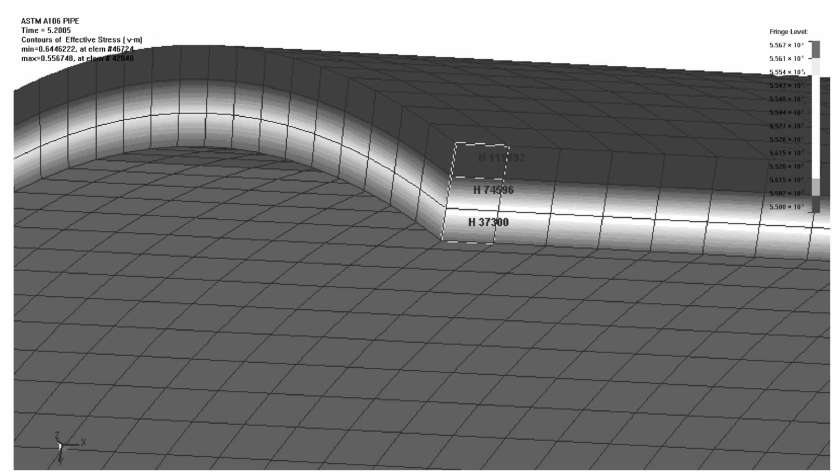
Figure 5. Boundary conditions [21].